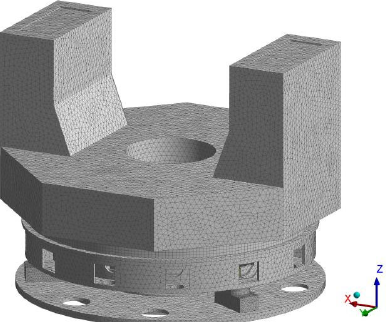
Figure 10. Mesh distribution diagram of the tracking frame’s equivalent parametric